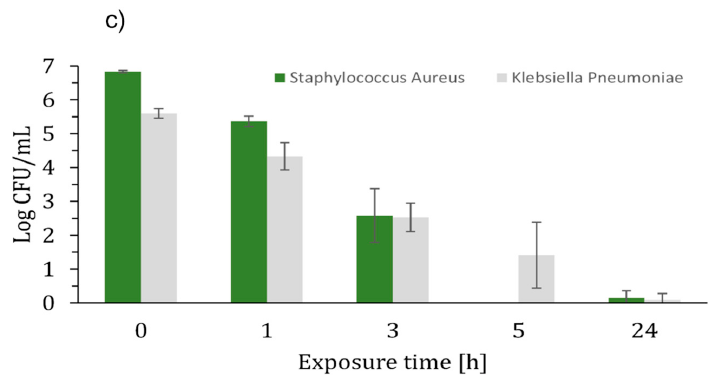
Figure 3. ( a , b ) Concentration of copper ions in water over multiple contacts of one stone with 1.9